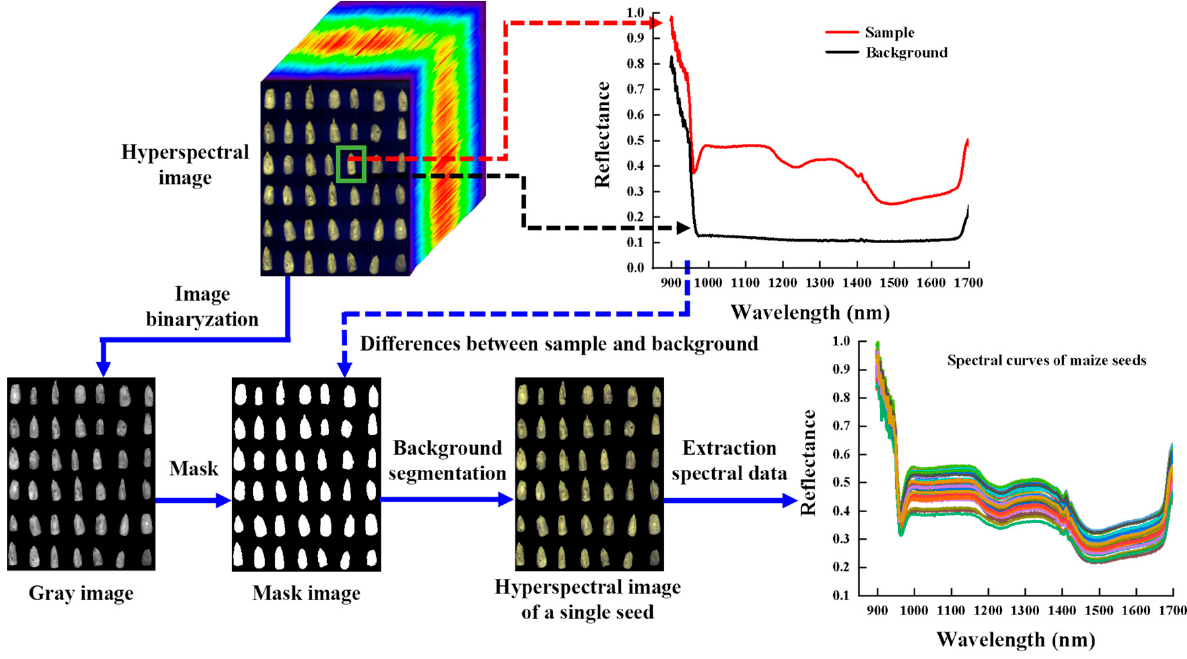
Figure 3. The process of hyperspectral image segmentation and spectral extraction.